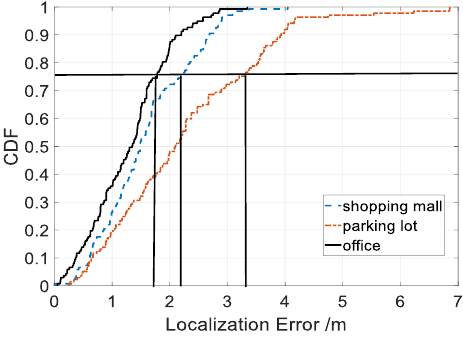
Figure 19. Localization accuracy in typical scenarios. Table 2. The localization error in typical scenarios using hybrid fingerprints.